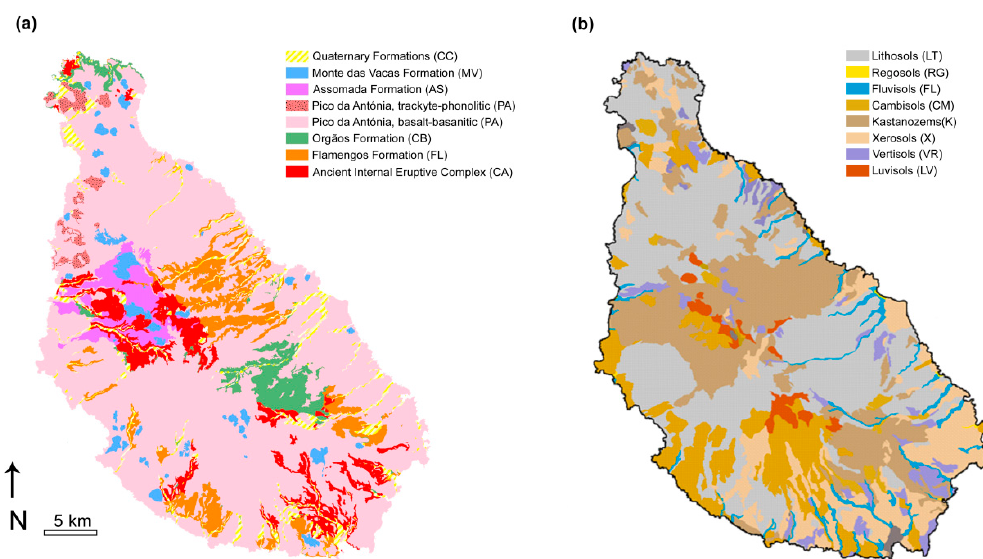
Figure 2. ( a ) Geological cartography of the island of Santiago, Cape Verde, adapted from [38]; ( b ) Adapted soil cartography of the island of Santiago according to FAO/UNESCO [39], adapted from [40].